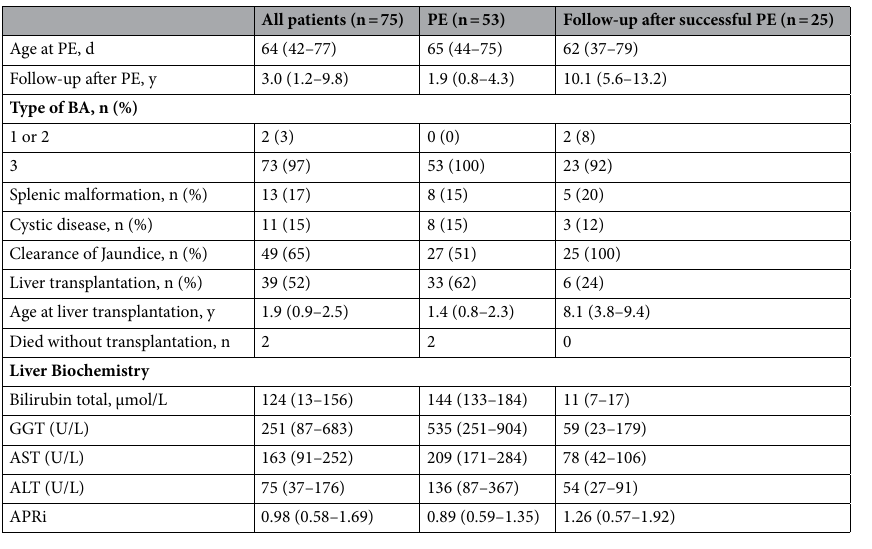
Table 1. Baseline patient characteristics. Data are median (IQR) or frequencies (%). Liver biopsies were obtained at portoenterostomy (PE) in 50 patients, during postoperative follow-up after successful PE in 22 patients, and both at PE and during follow-up in 3 patients.